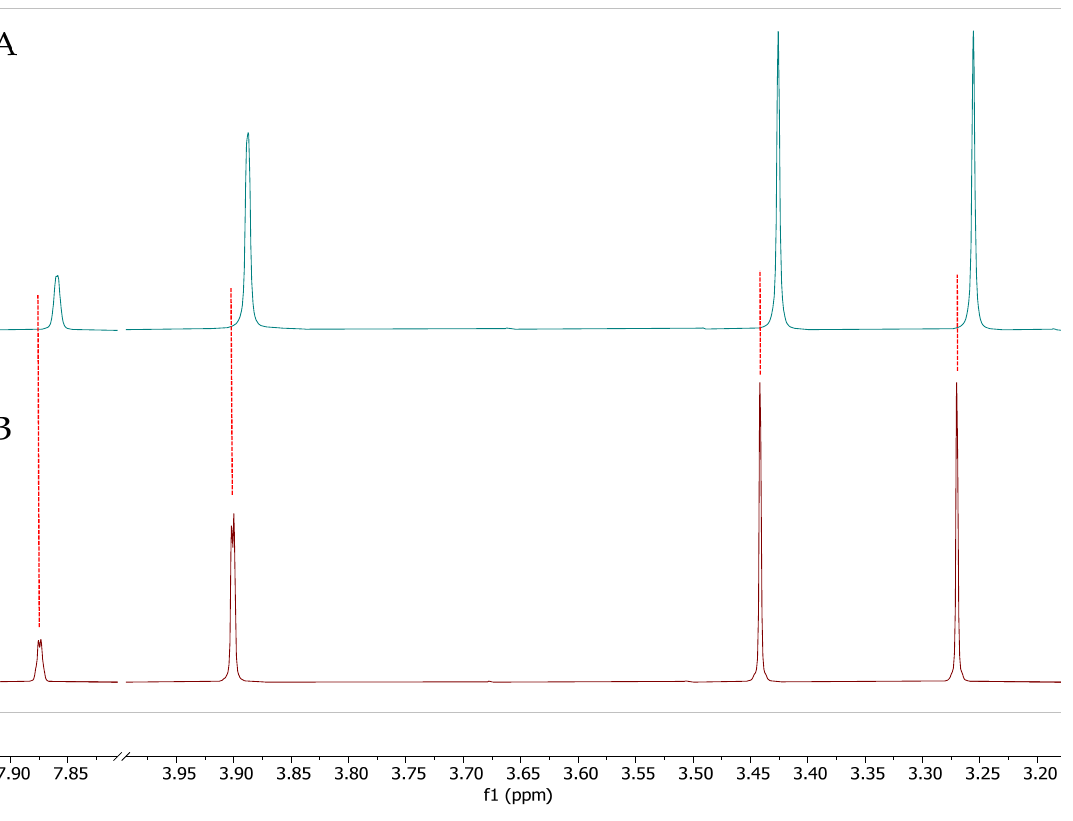
Figure 2. 1 H NMR spectra of ( A ) CEWCCE compared to the spectrum and ( B ) GCBE (99% Caffeine) in phosphate buffered D 2 O pD 7.1 operating at 299.99 MHz (Red: GCBE, Blue: CEWCCE). Dotted lines added for clarity of relative complexation shifts. Three methyl groups (H11”, H10”, H12”) with chemical shifts of 3.270, 3.442, and 3.900 ppm and another peak 7.876 ppm for aromatic protons (H8”).